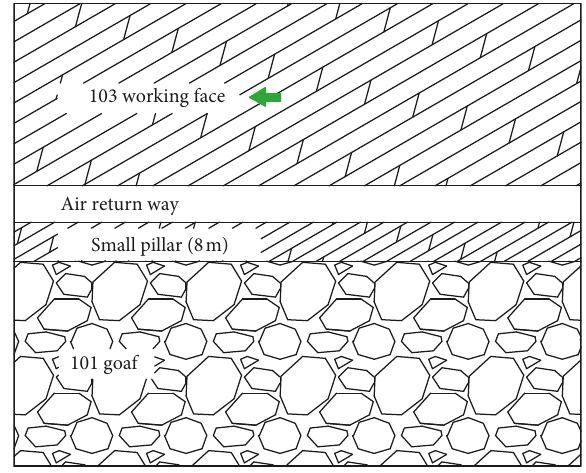
Figure 1: Schematic representation of a working face in the Gaojiabao coal